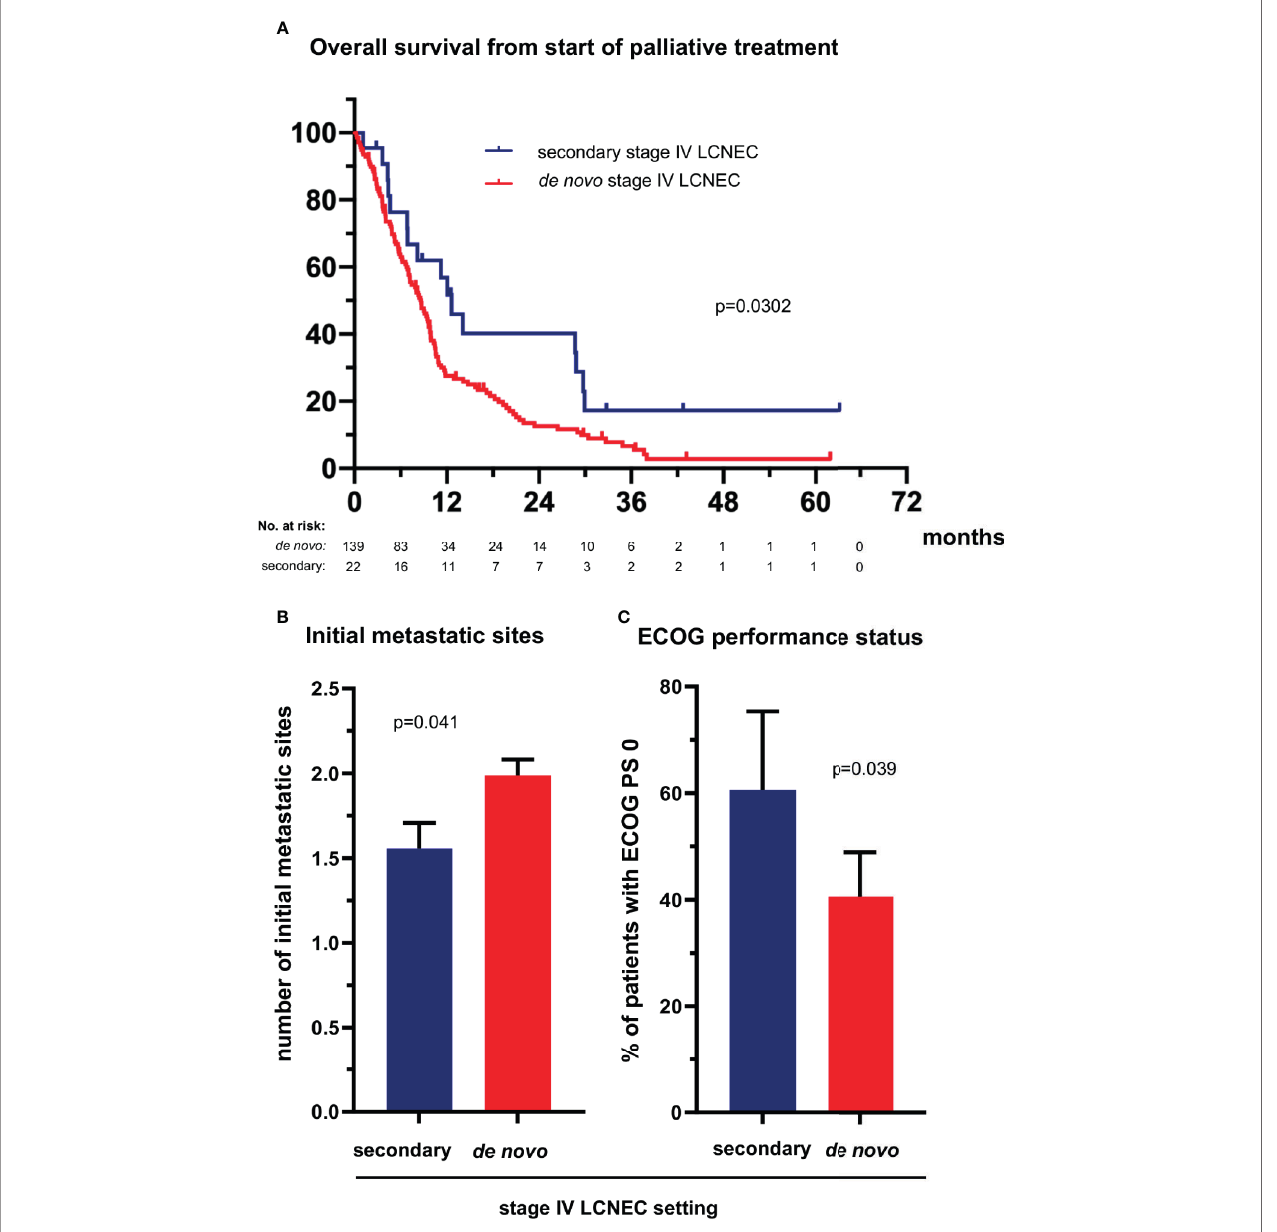
FIGURE 4 | The clinical pro fi le and survival of patients with secondary metastatic LCNEC. (A) The median overall survival from treatment start for stage IV disease was 12.6 (95% con fi dence interval [CI] 8.8-16.5) vs. 8.7 (6.9-10.4) months for patients with secondary vs. de novo metastatic LCNEC (logrank p = 0.030). (B) The median number of metastatic sites was 1.56 (standard error of the mean [SEM] 0.15) vs. 1.99 (SE 0.16, p = 0.041 with a t-test) for patients with secondary vs. de novo metastatic LCNEC. Error bars indicate SEM. (C) The percentage of cases with ECOG performance status (PS) 0 was 61% (20/33, CI 42-79) among patients with secondary vs. 41% (56/138, CI 32-49) among patients with de novo metastatic LCNEC (chi-square p = 0.038). Error bars indicate